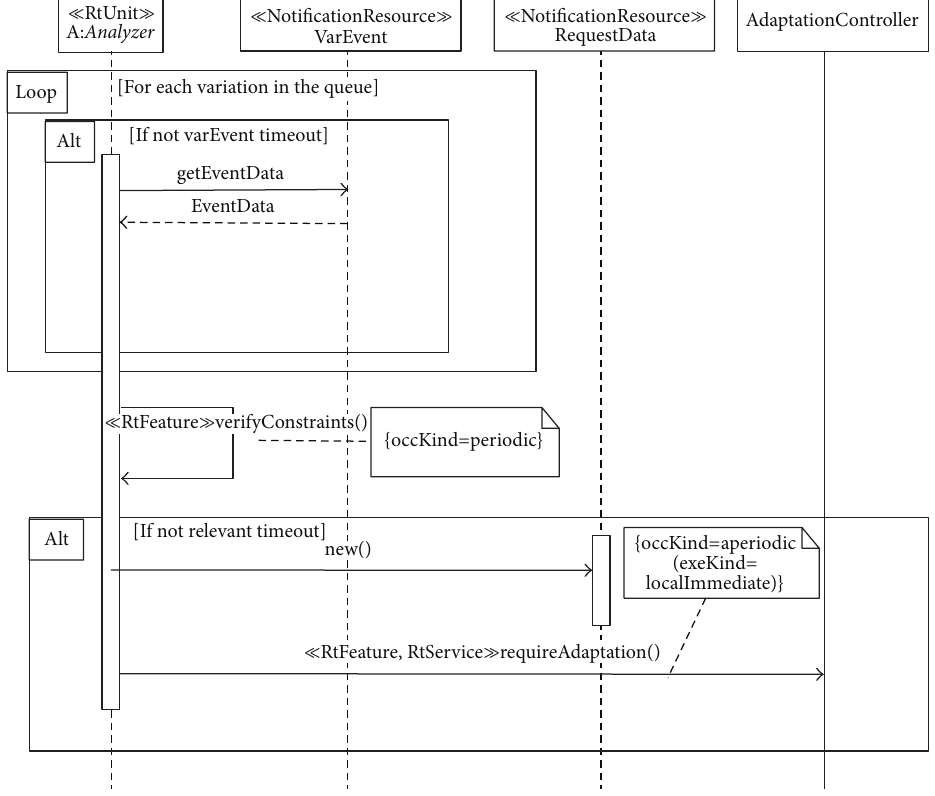
Figure 6: Behavioral view of the RTE Analyzer